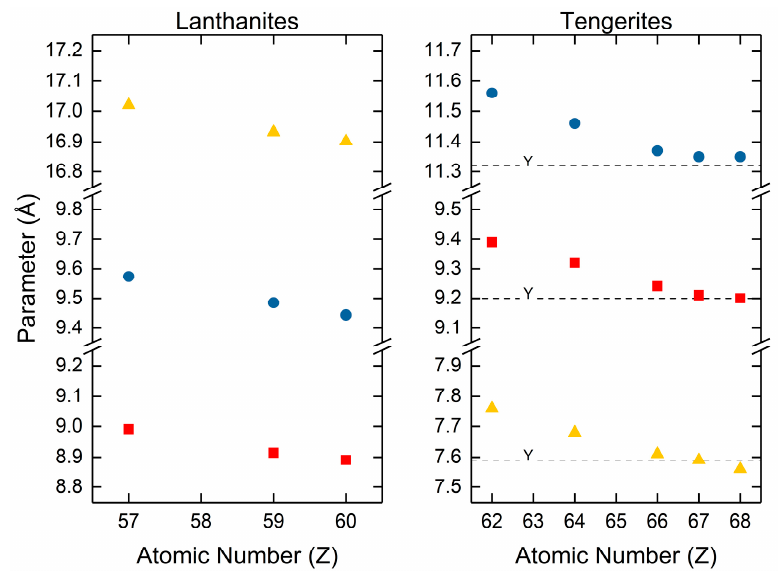
Figure 5. Lattice parameter data for the lanthanites and tengerites, the normal rare earth carbonate hydrates. Values for the lanthanites are from Caro and coworkers [120]. Values for the tengerites are from Wakita and coworkers [123].